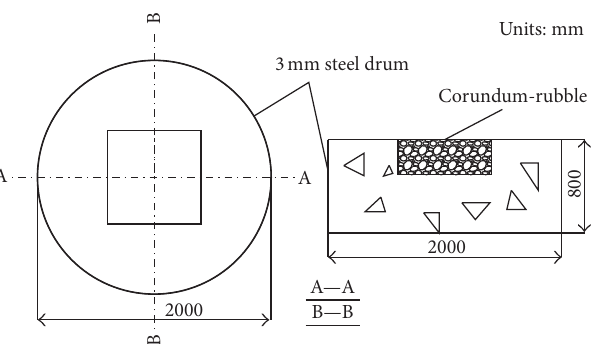
Figure 1: Projectile.